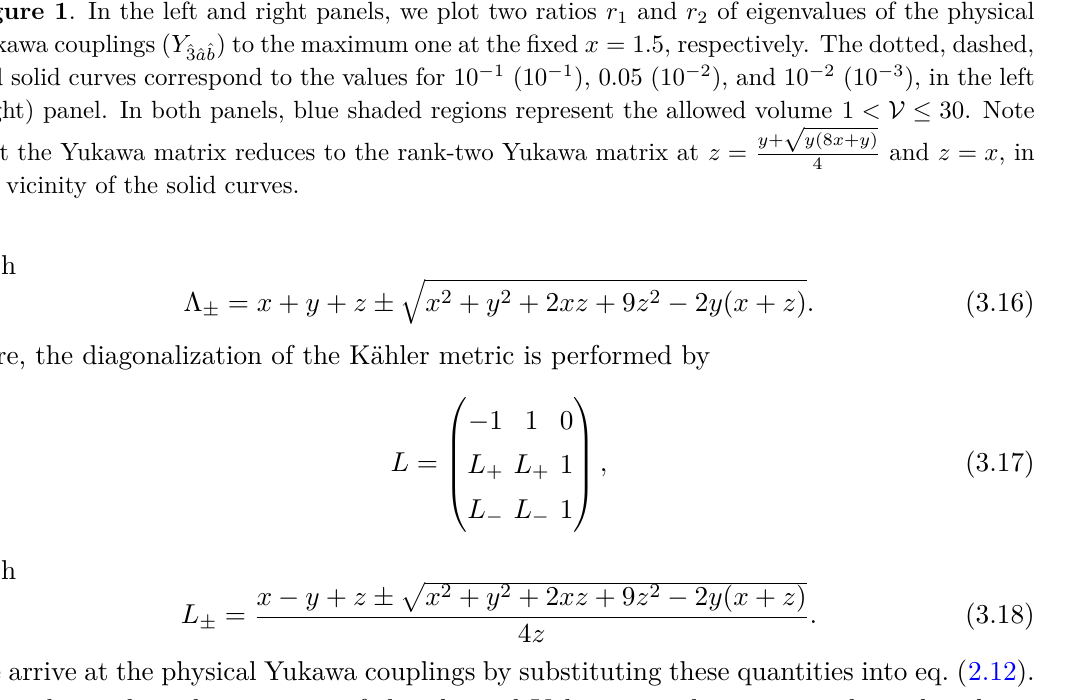
√ y (8 x + y ) and z = x , in 4